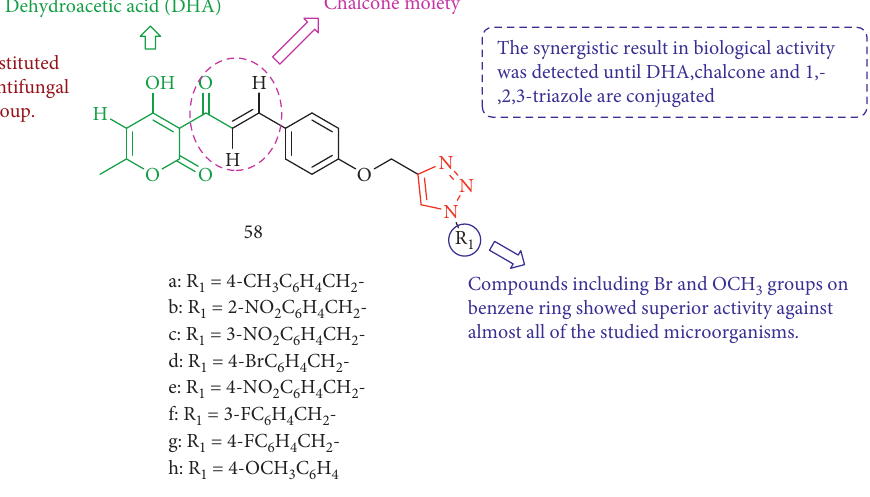
Figure 14: Chemical structure of dehydroacetic acid-chalcone-1,2,3-triazole hybrids.